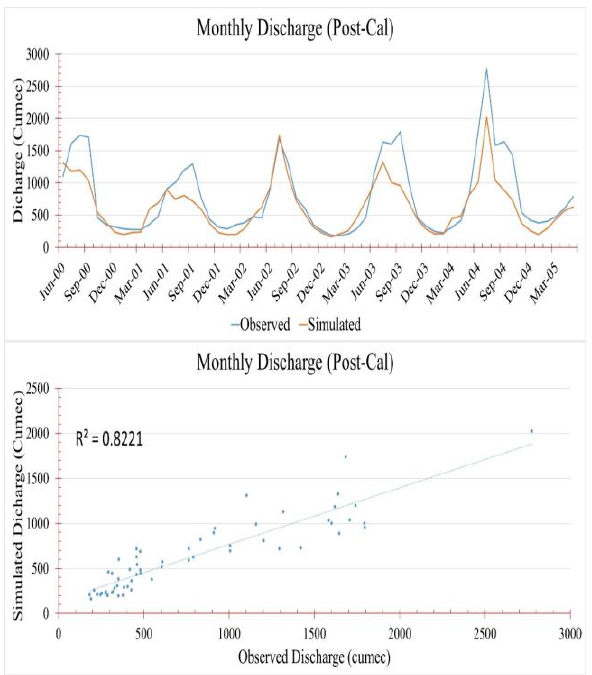
Figure 5 . Post Calibration Scenario